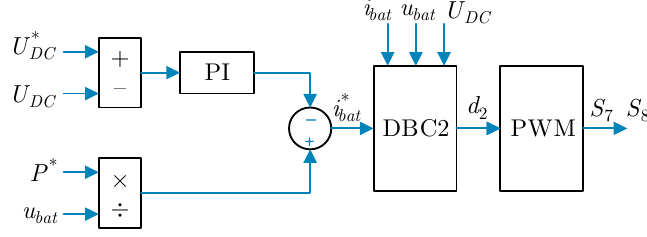
/ DC converter control